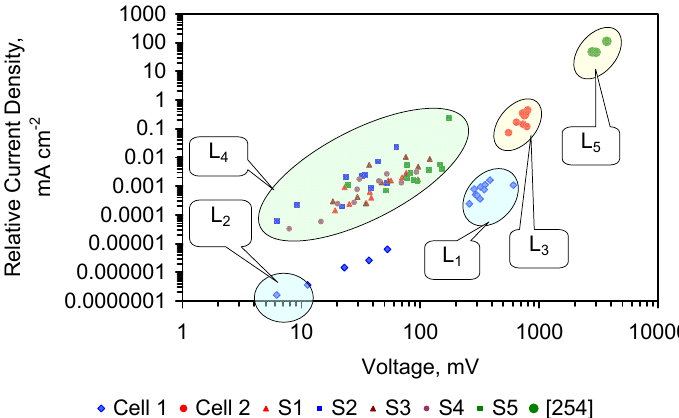
Figure H1. Relationship between current density and voltage associated with ZVM